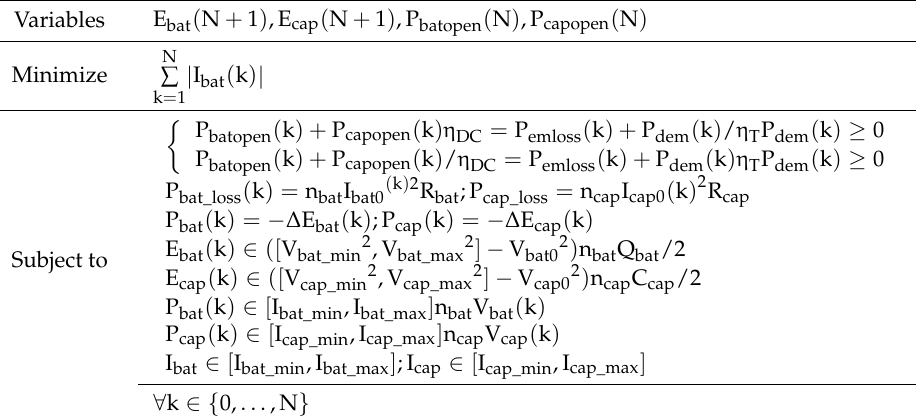
Table 4. Convex optimization function of hybrid energy storage system